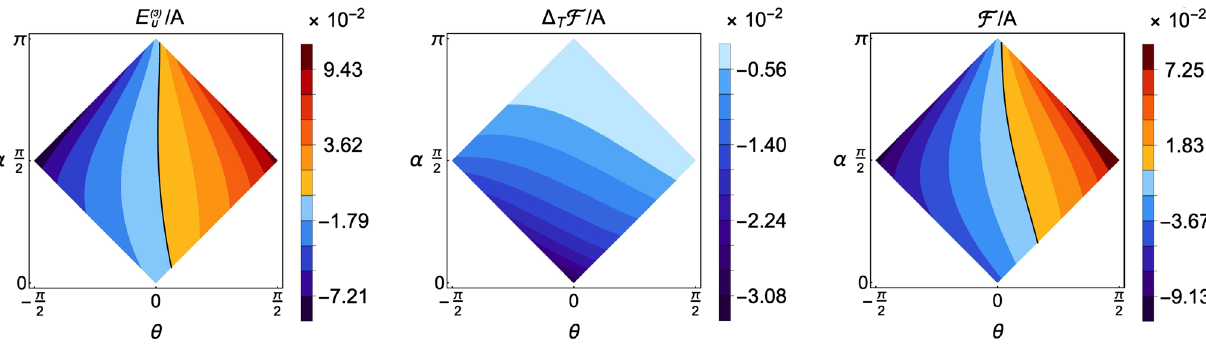
Fig. 4 Quantum vacuum energy per unit area at T = 0 (left), thermal correction Δ T F / A (center) and total Helmholtz free energy per unit area (right) as functions of the parameters α and θ . In these plots, T = 0 . 55 , n 1 = 0 . 5 and L =